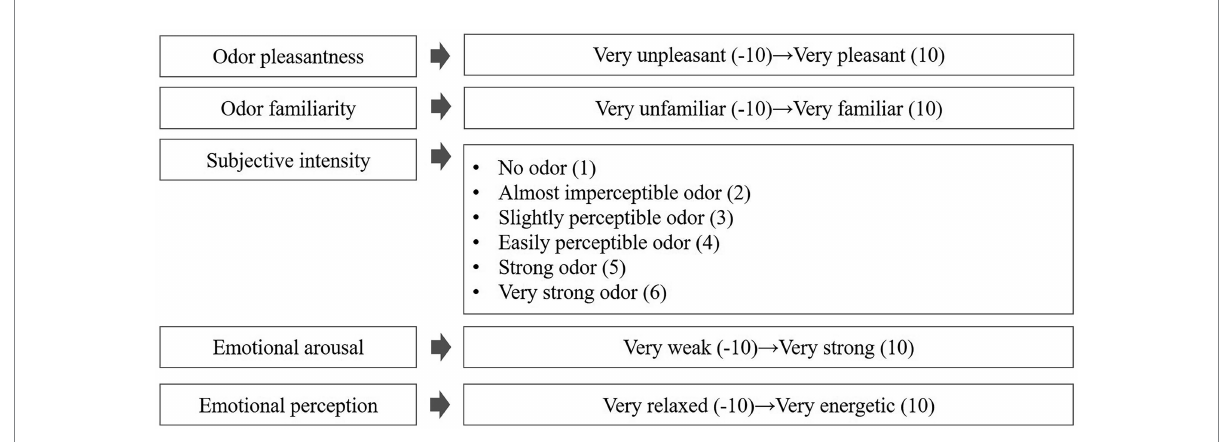
FIGURE 1 Contents of the questionnaire and specific evaluation index scores. The corresponding score range was shown in